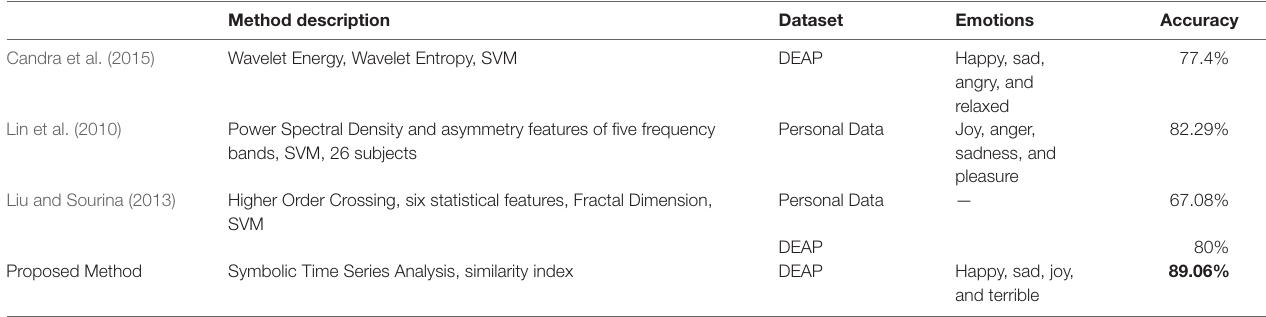
TABLE 3 | Comparison of different studies for emotion recognition using EEG—four groups of emotions.